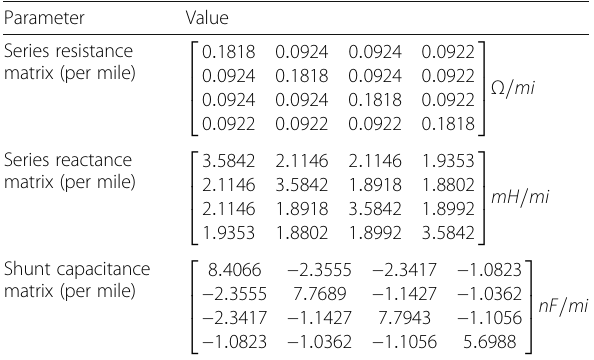
Table 4 Series resistance, series reactance and shunt capacitance matrices of the 34.5 kV μ Grid circuit Parameter